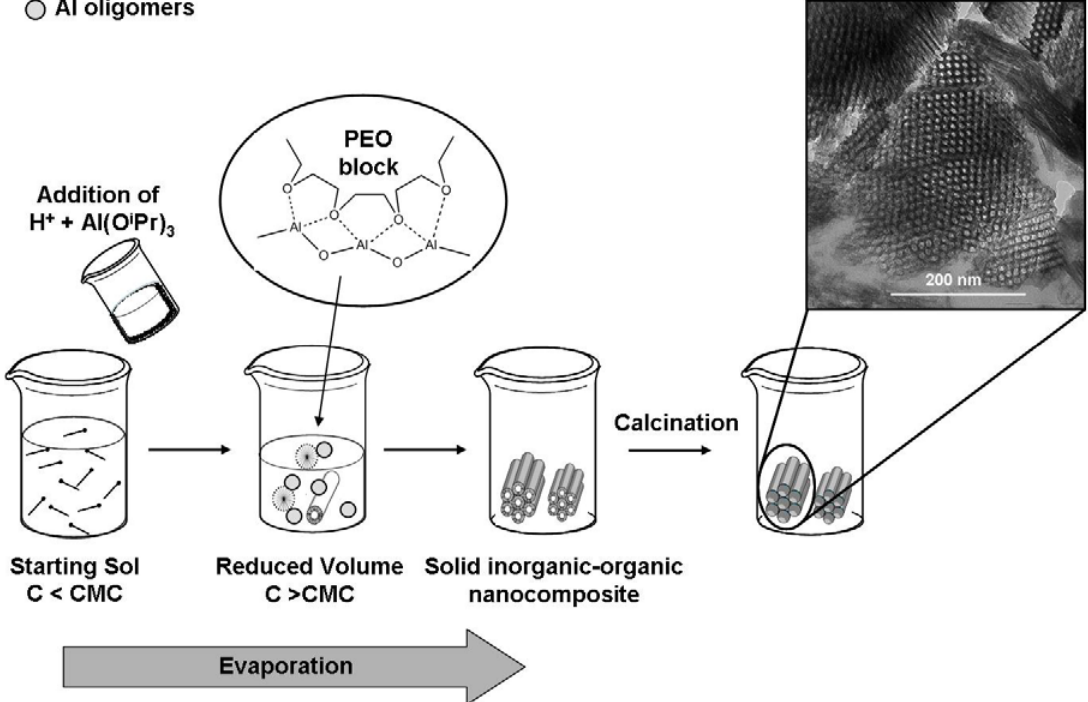
Figure 1. Schematic depiction of the formation of the nanostructured mesoporous alumina via the evaporation-induced self-assembly mechanism (EISA). The TEM image was taken from our own preparation (see experimental section) of an as-synthesized alumina material showing the 2D-hexagonally arrangement of mesopores (calcined at 400 °C for 4